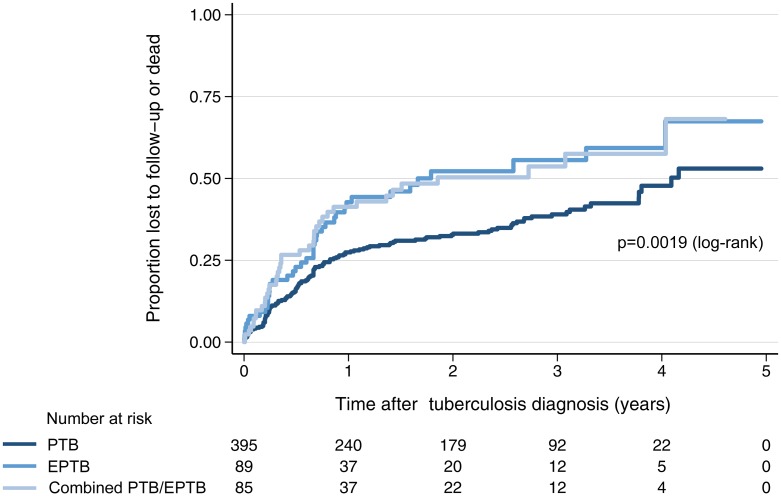
Kaplan-Meier curves for composite outcome of lost to follow-up/dead in patients with tuberculosis.